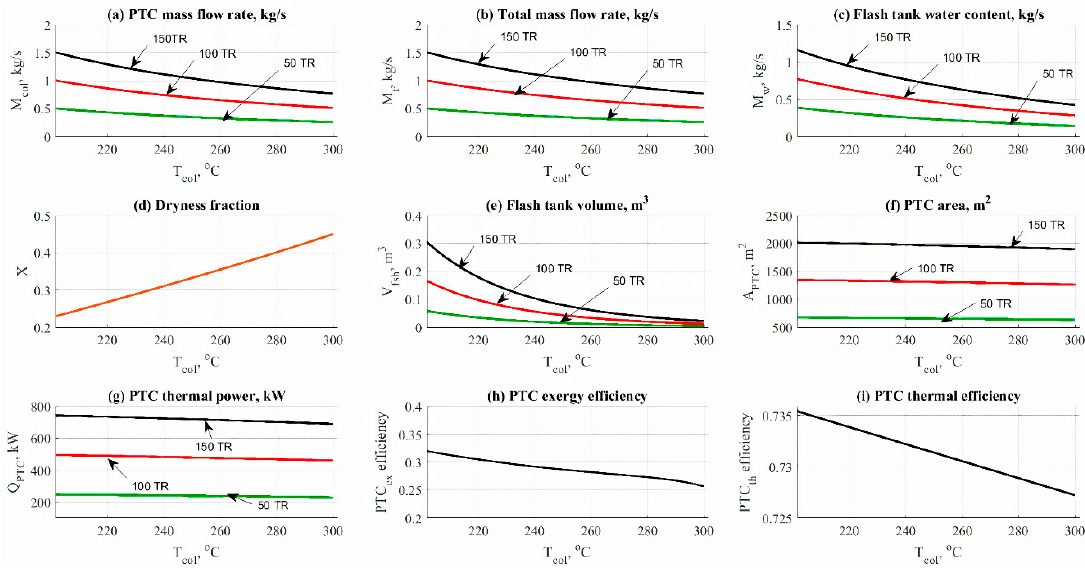
Figure 8. Data results based on the effect of PTC outlet top temperature.